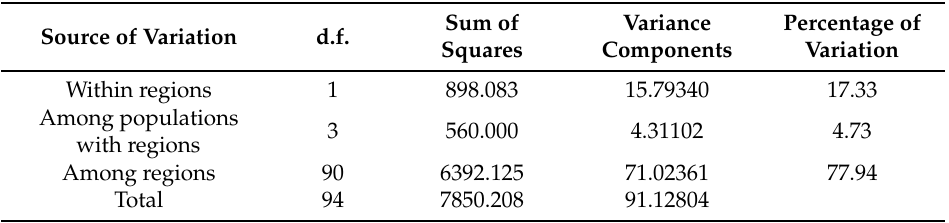
Table 3. Analysis of molecular variance (AMOVA) of 95 A. conjugella between the two major (East and west) regions using 410 AFLP markers.